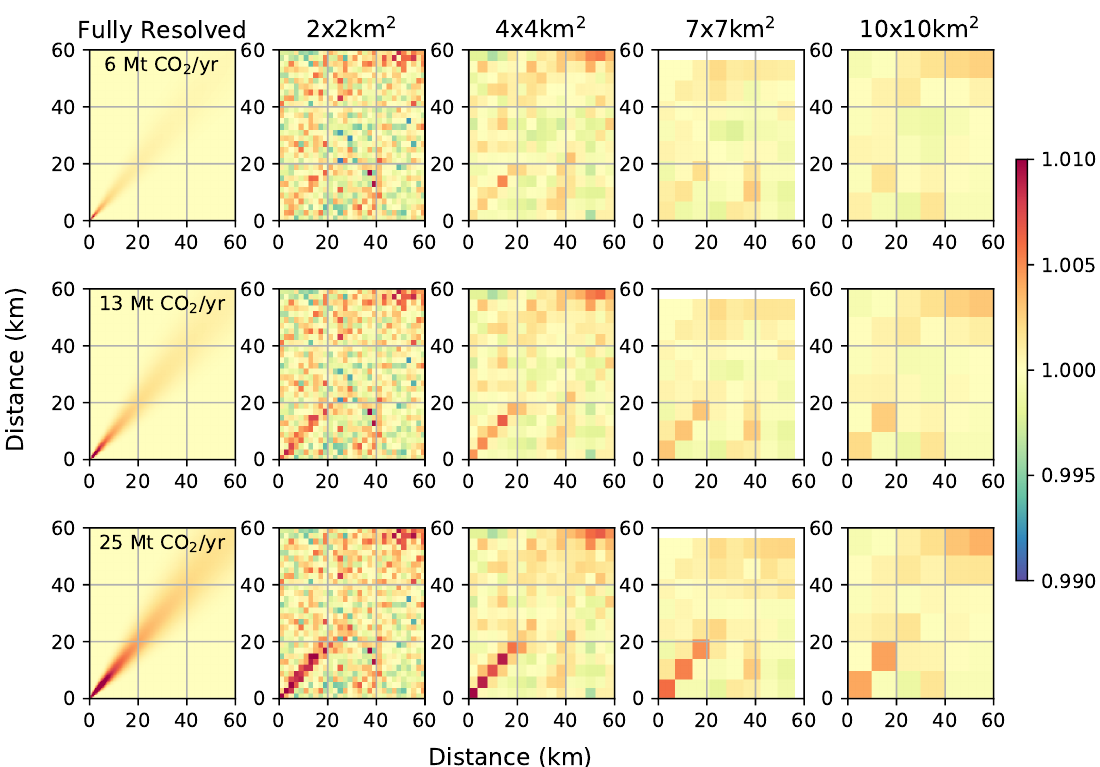
Figure 6. Simulated and model XCO 2 observations relative to a constant 400 ppm background with topography, footprint, albedo, and stability class biases. Panels are as in Figure 1.